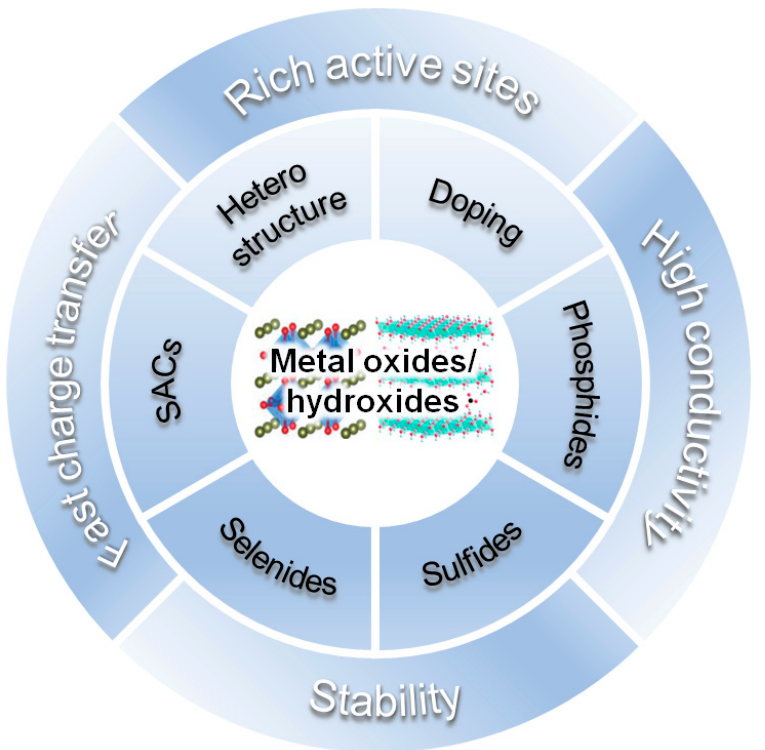
Figure 2. Proposed strategies to realize the improved alkaline water spli tt ing by functionalities and advantages in multicomponent metal oxides and hydroxides. advantages in multicomponent metal oxides and